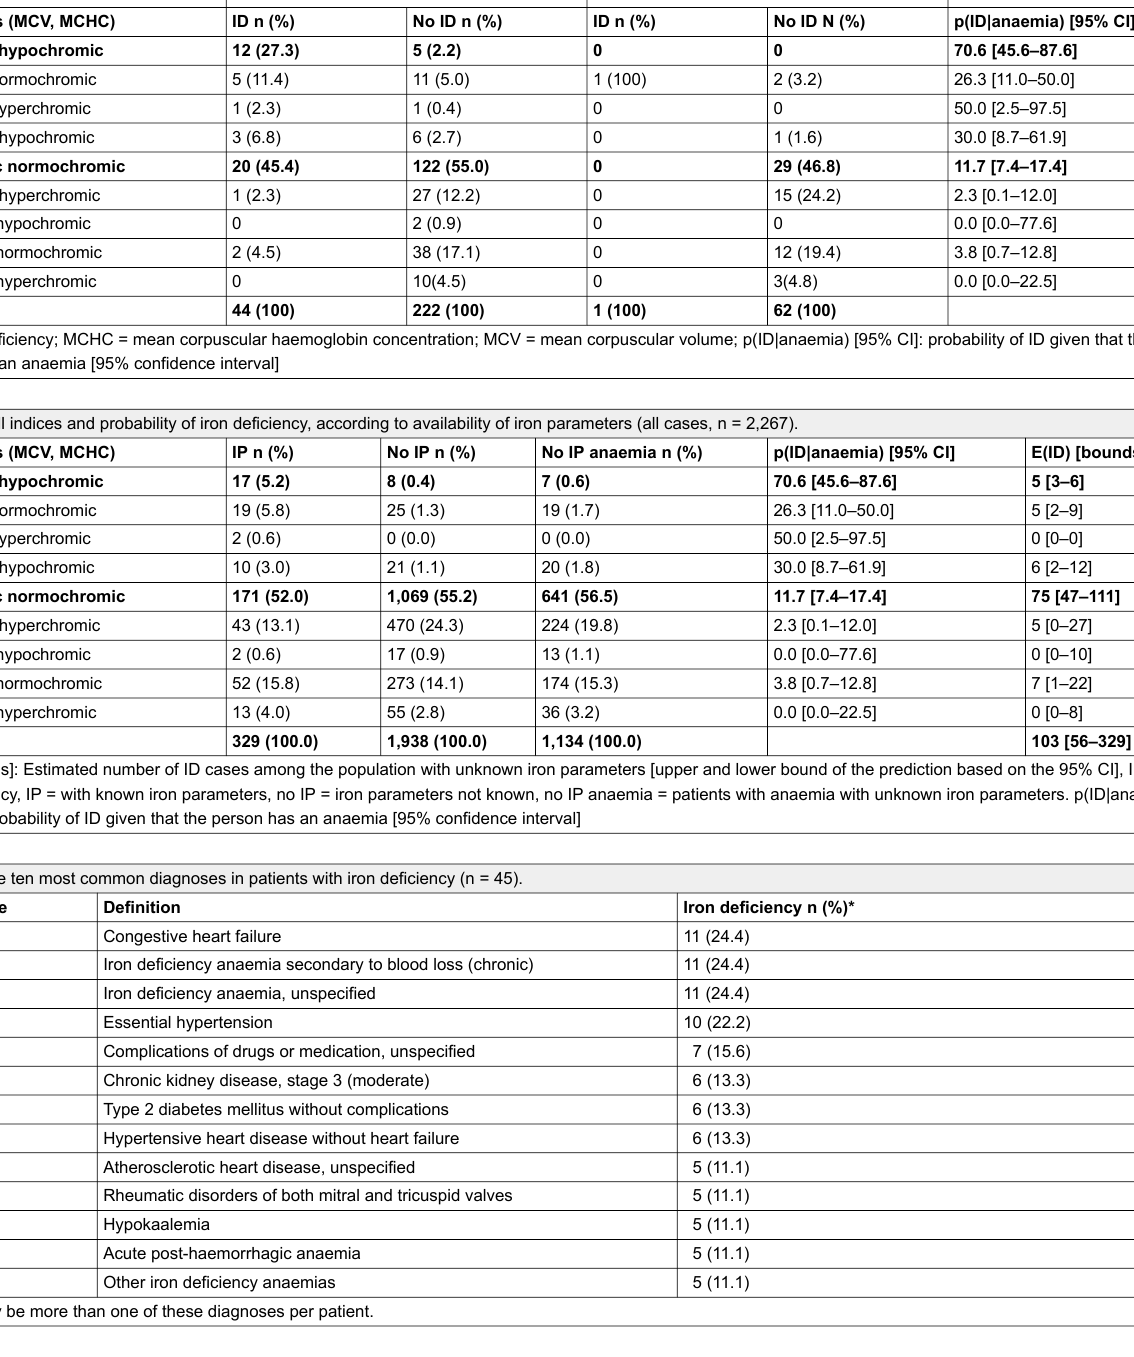
Table 4: Cell indices and probability of iron deficiency in cases with known iron parameters, according to anaemia status (n = 329 cases). Anaemia No Anaemia